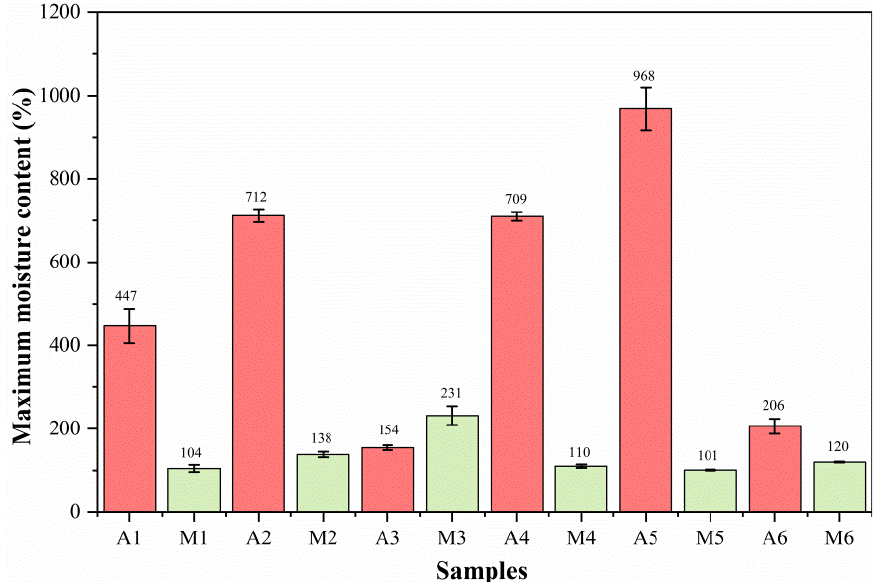
Figure 2. The maximum water content (MWC) of waterlogged archaeological wood samples (A1–6) and modern samples (M1–6).